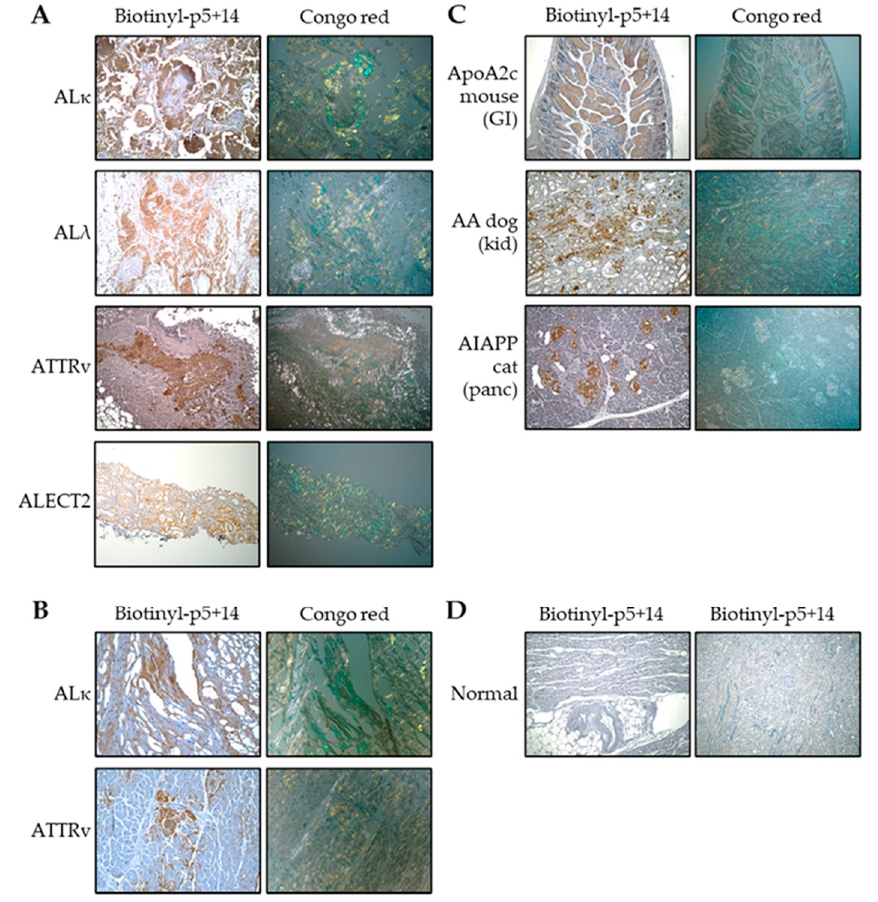
Figure 1. Peptide histochemistry and Congo red analysis of tissue sections demonstrate the pan- amyloid reactivity of p5+14. The brown-colored stain of biotinyl-p5+14 can be seen in ( A ) patient- derived renal tissues, magnification 10 × ; ( B ) patient-derived cardiac tissues, magnification 20 × ; and ( C ) animal-derived tissues, magnification 10 × . The peptide colocalized to Congophilic regions within tissue, as demonstrated with green–gold birefringence in consecutive tissue sections. ( D ) Normal heart (left) and kidney (right) tissues were negative with biotinyl-p5+14, magnification 10 ×